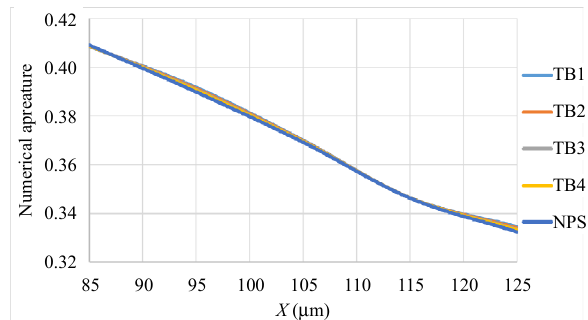
Fig. 13 NA of the proposed sensor for various tuberculosis-infected samples versus X at 2.2 THz.